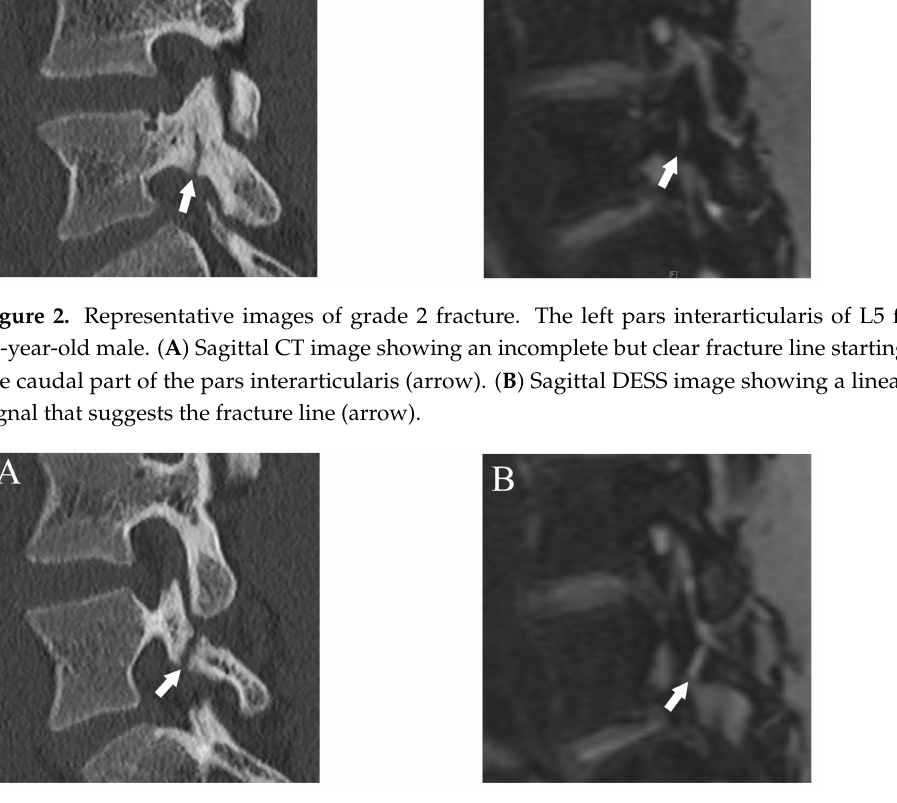
Figure 3. Representative images of grade 3 fracture. The right pars interarticularis of L5 from a 16-year-old male. ( A ) Sagittal CT image showing a complete fracture across the whole pars interarticularis (arrow). ( B ) Sagittal DESS image showing a linear high signal corresponding to the complete fracture